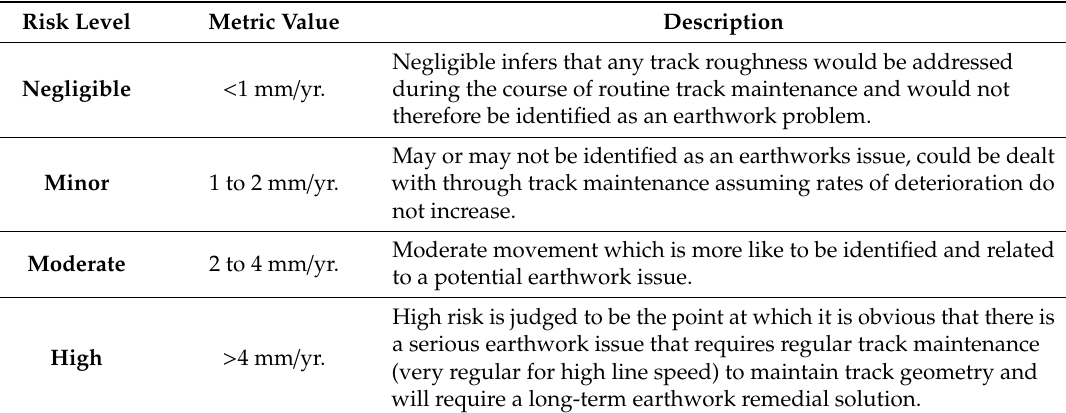
Table 2. Embankment instability metric threshold